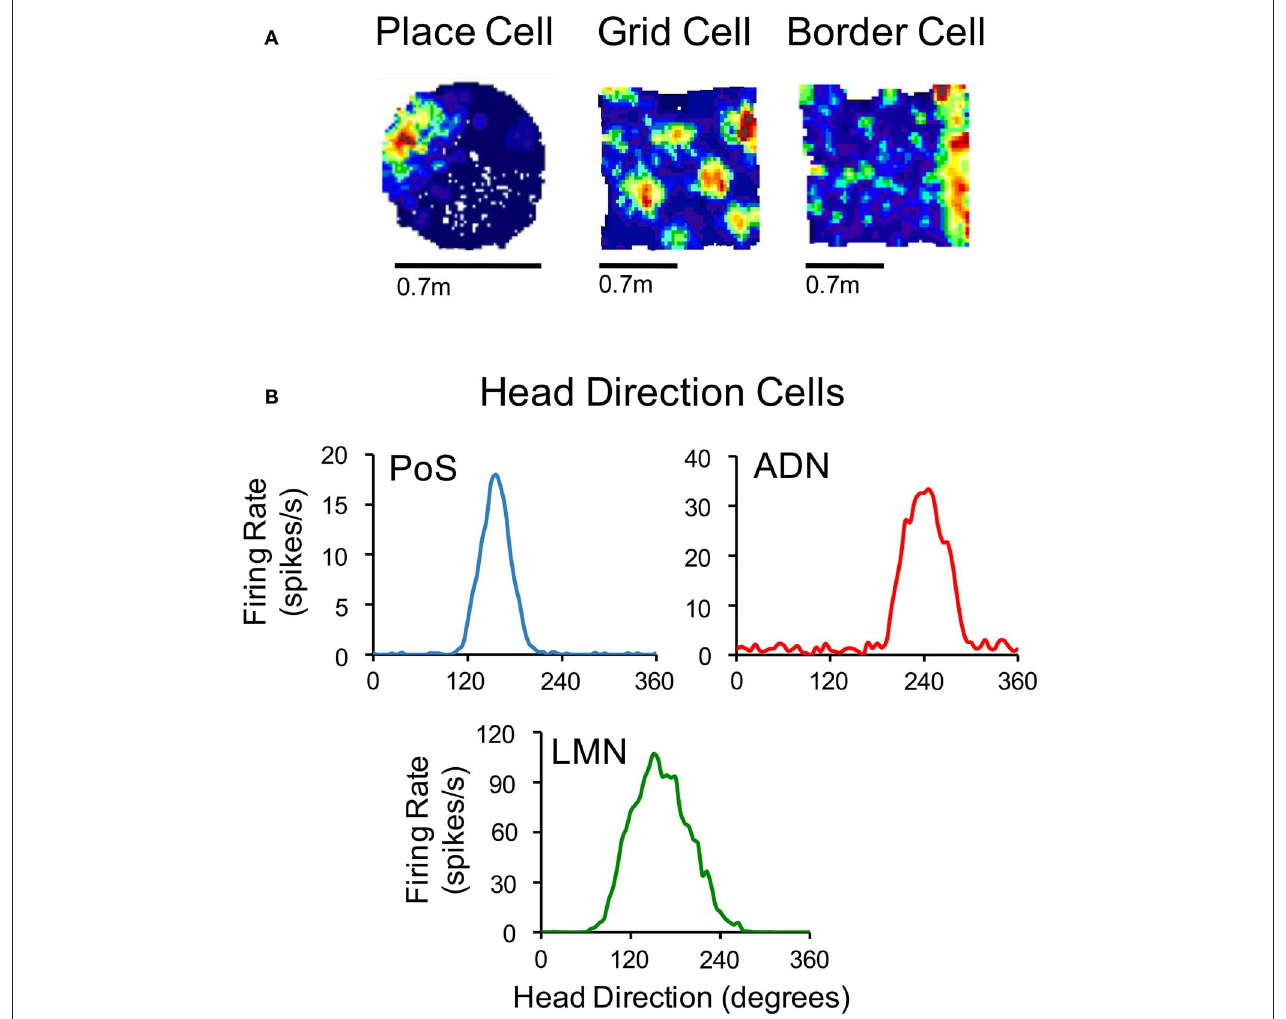
FIGURE 1 | (A) Color-coded rate maps for a hippocampal place cell, a medial entorhinal grid cell and a medial entorhinal border cell (Red, maximum firing rate; blue, minimum firing rate). (B) Firing rate by HD plots for representative HD cells recorded in the postsubiculum (PoS), anterodorsal thalamus (ADN), and lateral mammillary nuclei (LMN).